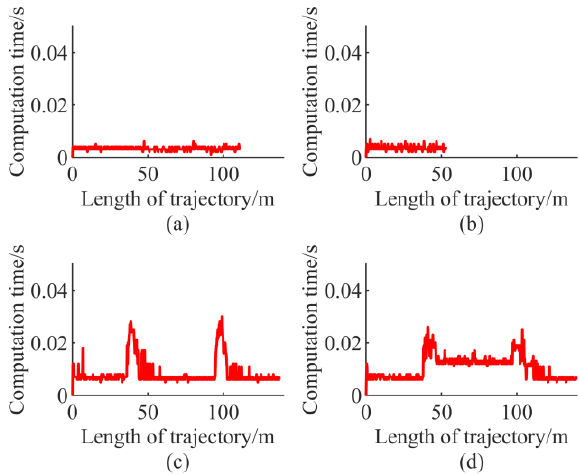
Figure 18. The computation time when velocity is 4 m/s. ( a ) LMPC. ( b ) LEMPC. ( c ) NMPC. ( d ) NEMPC.